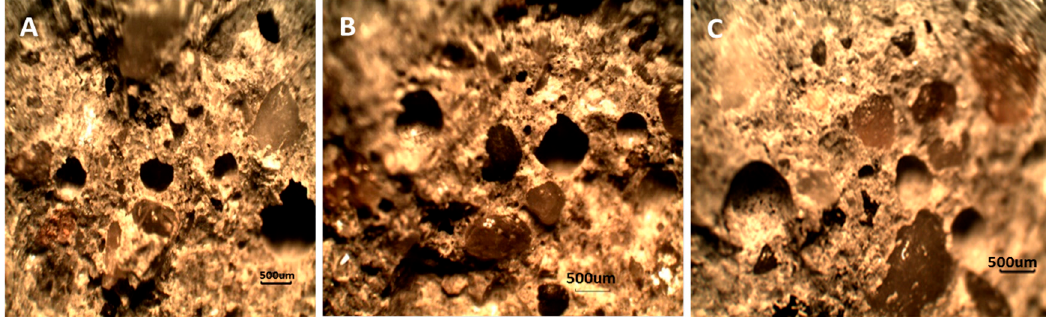
Figure 4. Stereo microscope images of mortar specimens performed with ( A ): PTW; ( B ): STW; and ( C ): DW. The image was taken at 30× magnification.